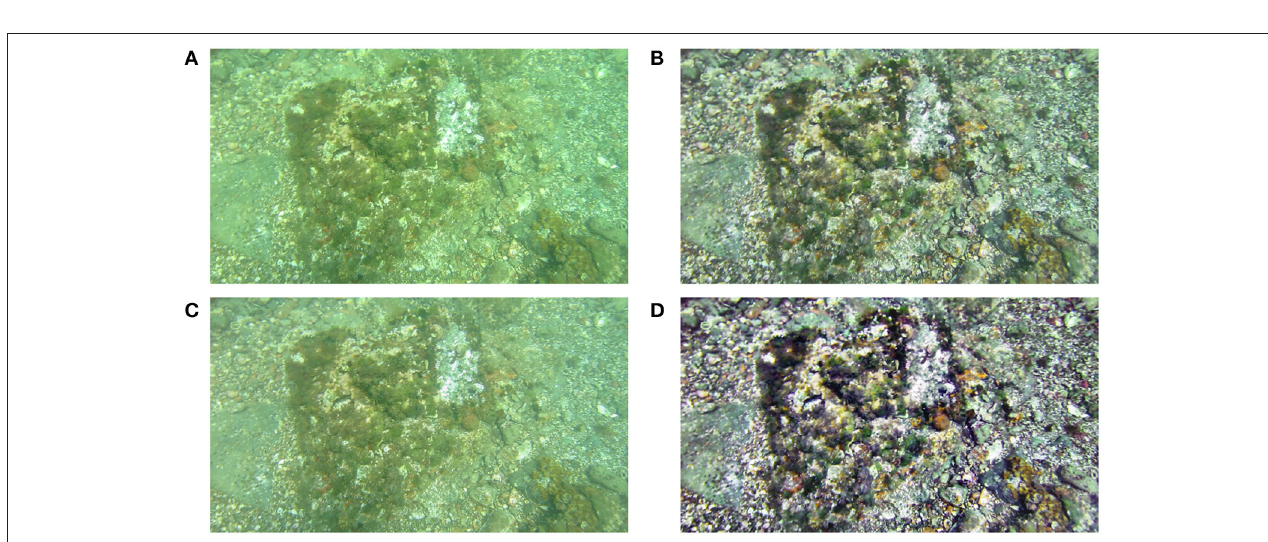
FIGURE 3 | Example of an underwater image of a seafloor (A) processed by the fusion algorithm (B) . Images (C) and (D) depict the two enhanced images created by the algorithm. The result is a fusion of the two enhanced